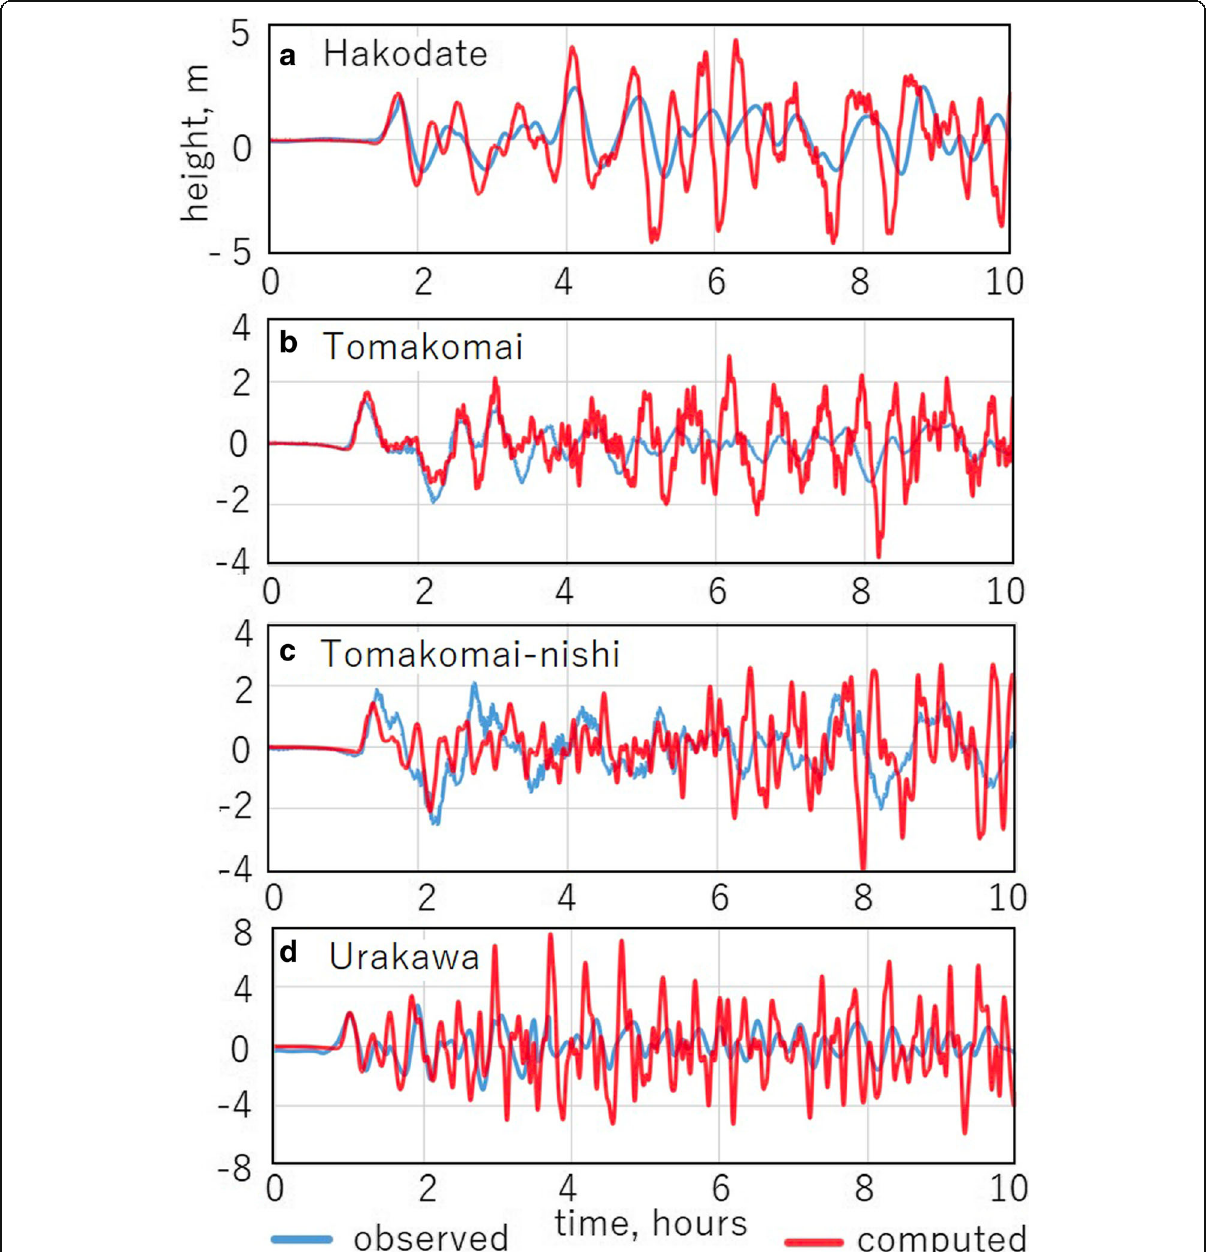
Fig. 2 Comparison of observed (blue) and computed (orange) tsunami waveforms by solving the linear shallow water equations at four tide gauges, in a Hakodate, b Tomakomai, c Tomakomai-nishi, and d Urakawa, shown in Fig.